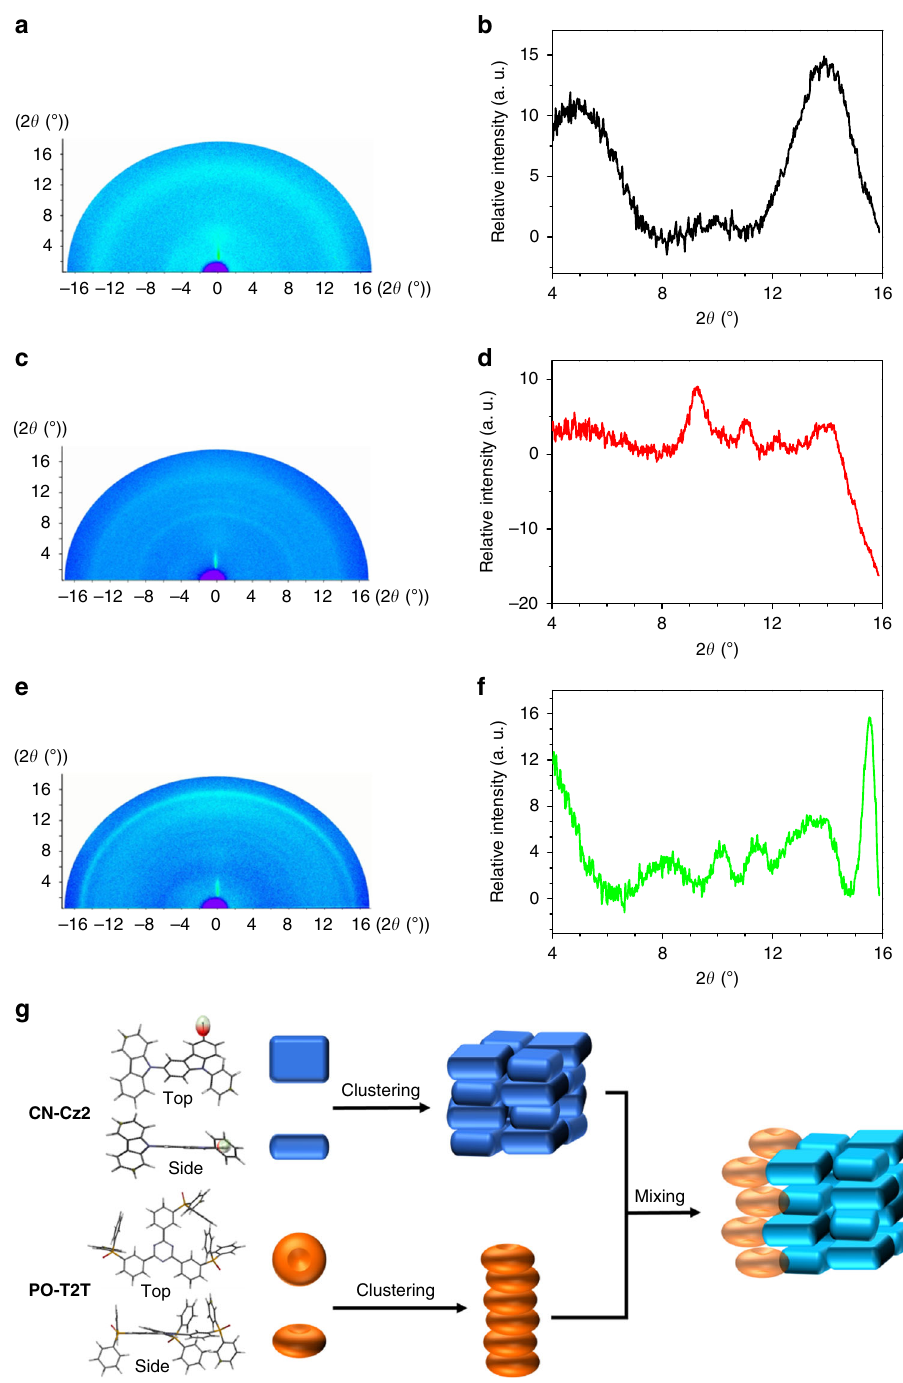
Fig. 4 The GIXD character. 2D GIXD patterns for ( a ) CN-Cz2, ( c ) CN-Cz2:PO-T2T (1:1), ( e ) PO-T2T and respective 1D GIXD patterns ( b , d , f ). g The molecular packing for CN-Cz2 grain domain, PO-T2T grain domain, and the in-plane interaction between CN-Cz2 and PO-T2T grain domains. Note that the 1D GIXD pro fi le of PO-T2T shows a strong diffraction peak at 2 θ = 15.5 o , corresponding to a well correlated π – π stacking with a d-spacing of 3.8 Å as illustrated in g . In CN-Cz2:PO-T2T (1:1) codeposited fi lm, the diffraction corresponding to the π – π stacking of PO-T2T shifts to larger d-spacing as indicated by the deconvolution analyses. The interplanar spacings of the two components in the codeposited fi lm are both larger than those in fi lms of individual components, indicating interaction of the two components in the co-deposited fi lm as depicted in